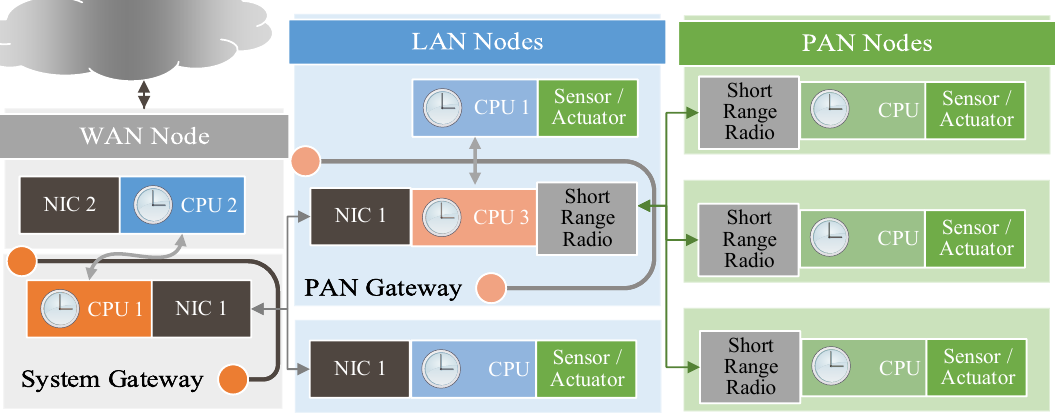
Figure 1. An Internet of Things deployment utilizing a (Wireless) Sensor Network to interact with the physical world. A Wide Area Network (WAN) node on the left is connected to the Internet over a Network Interface Controller (NIC), and connected to the Local Area Network (LAN) at the center using another NIC. One of the LAN nodes is connected to the Personal Area Network (PAN) on the right, which realizes the Sensor Network. Each processor in the system has its own notion of time due to different clock implementations. The network entities acting as gateways are explicitly